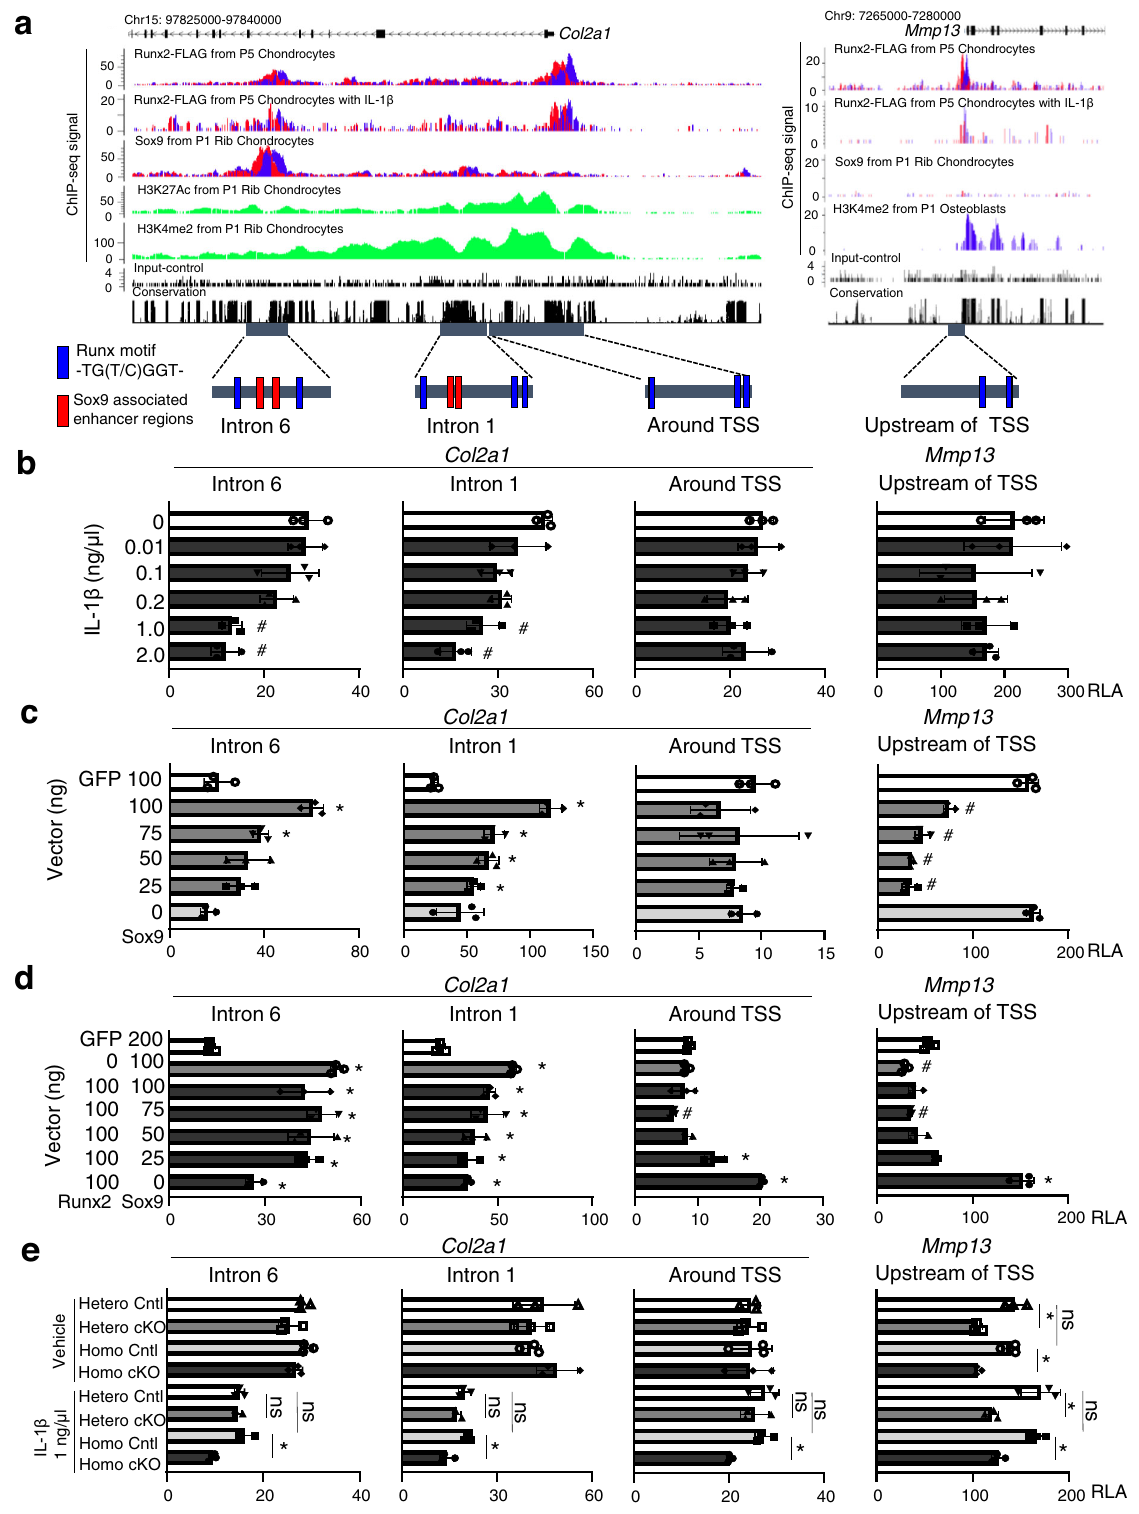
Fig. 6 | Transcriptional regulation of Col2a1 and Mmp13 by Runx2 and Sox9. a CisGenome browser screenshots showing Runx2 and reference engagement around Col2a1 (Chr15: 97,825,000 − 97,840,000) and Mmp13 (Chr9: 7,265,000 − 7,280,000). Lower panels show genomic regions cloned into the pGL4.10[luc] vector. b Luciferase activities of enhancer regions in mouse chon- drocytes exposed to various concentrations of IL-1 β . c , d Luciferase activities of enhancer regions in mouse chondrocytes transfected with various ratios of Runx2